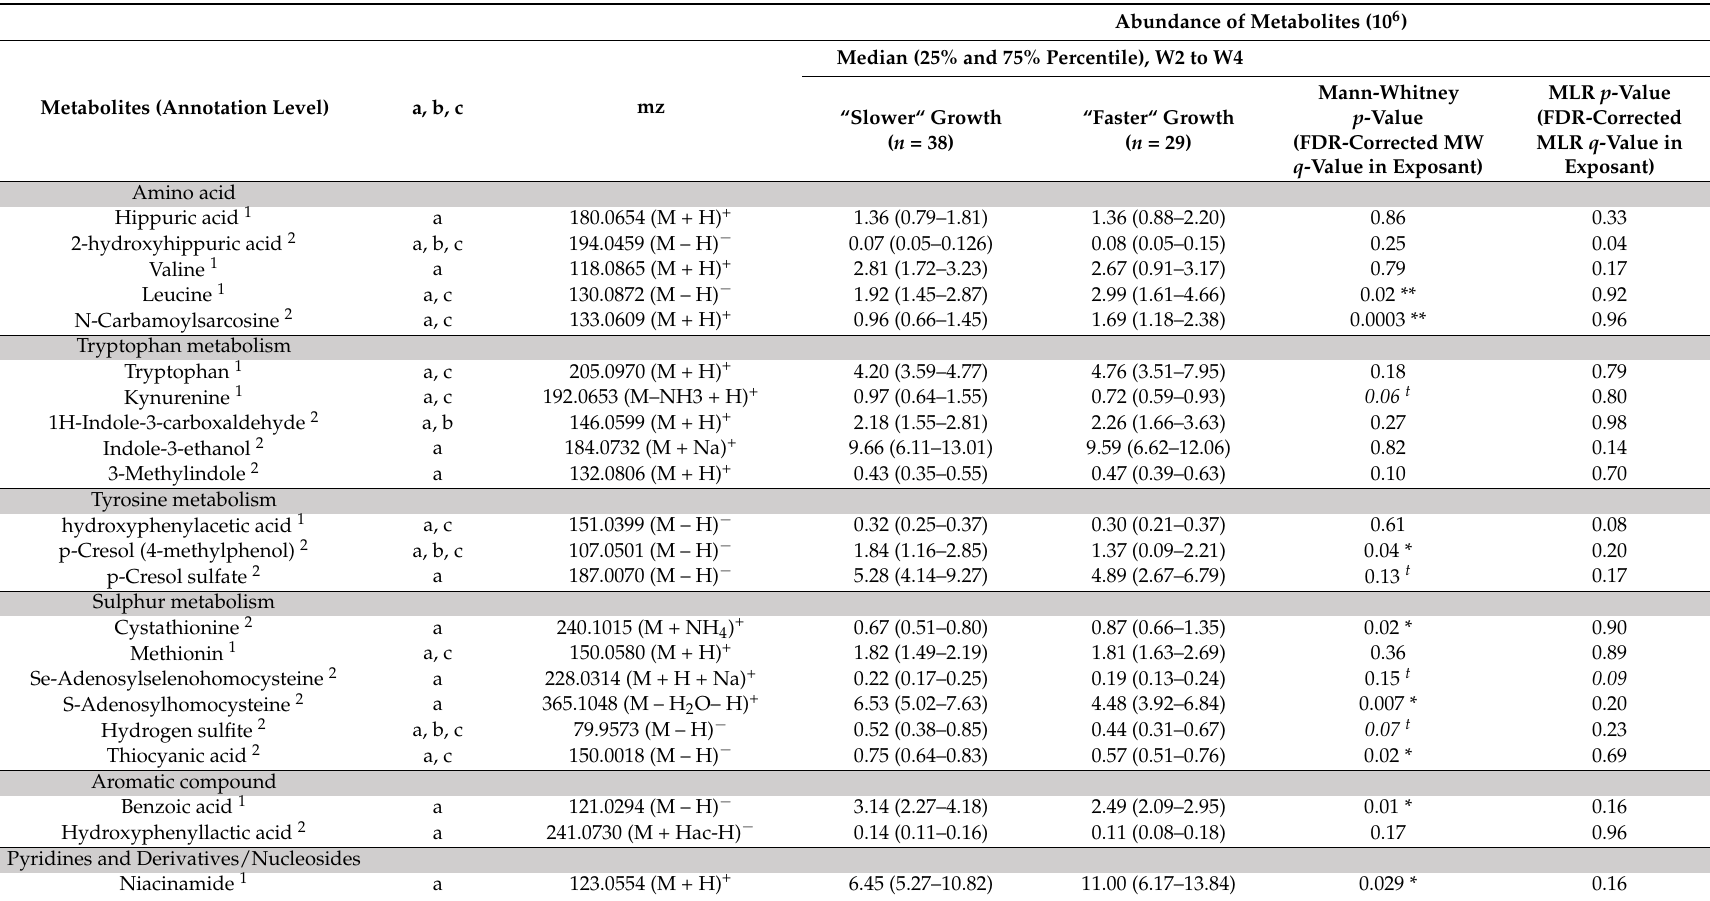
Table 3. Abundance (10 6 ) of annotated metabolites that discriminated metabotypes of breast milk provided to preterm infants with “faster” or “slower” growth during the W2 to W4 lactation